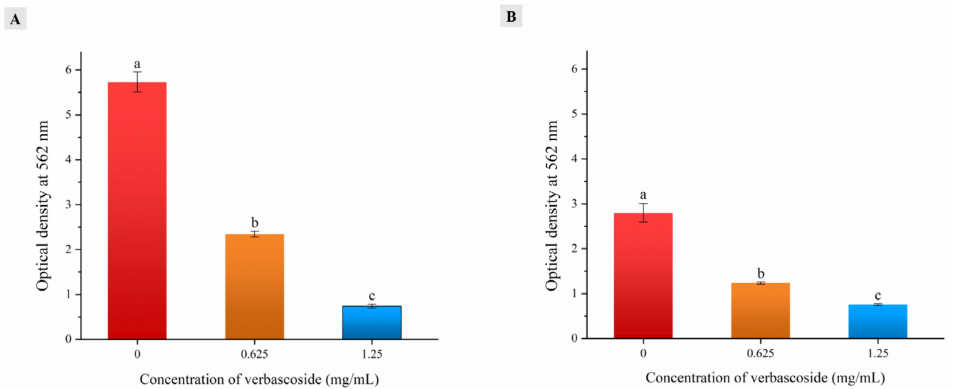
Figure 5. Effects of various concentrations of verbascoside on bacterial biofilms. ( A ) MDR Staphy- lococcus aureus SA-596. ( B ) MDR Pseudomonas aeruginosa PA-69. The values are expressed as the mean ± standard deviation (n = 3). a–c Values with different lowercase letters are significantly different at p <